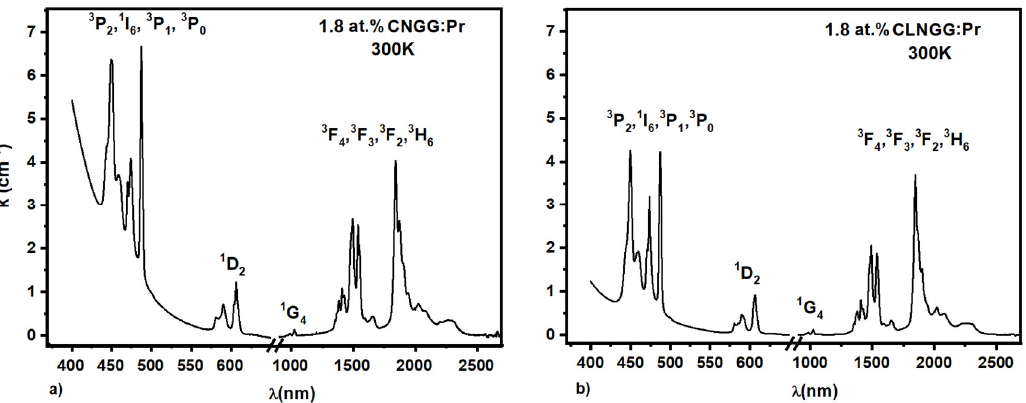
Figure 10. Absorption spectra of Pr 3+ ions in CNGG:Pr ( a ) and CLNGG:Pr ( b ) crystals. (Reprinted with permission from Ref. [24], copyright 2019, Elsevier).